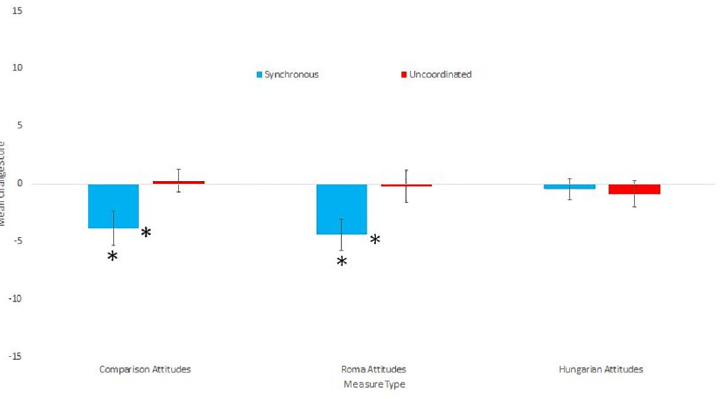
Fig 3. Means and standard errors for the attitude change scores.